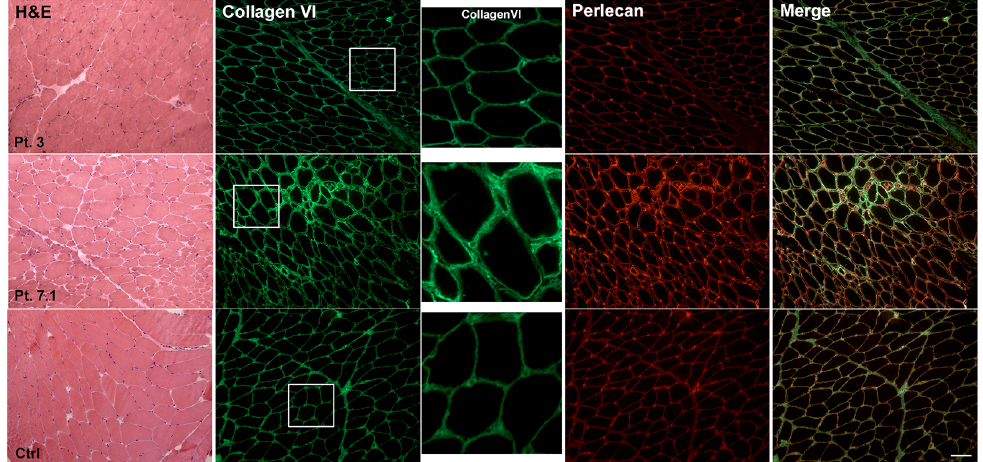
Figure 2. Histology and immunofluorescence on COL6-RM in adult patients. H&E staining shows marked fiber size variability and hypotrophic fibers, predominantly of type II (ATPase staining, data not shown) in Pt 7.1, and no significant changes in Pt 3. Ctrl: aged-matched control muscle biopsy. Scale bar: 50 µ m. Double fluorescent staining for collagen VI (green) and perlecan (red) showed in Pt 3 a staining quite similar to control and a strong signal at the membrane and at the endomysium in Pt 7.1. The inset identifies the high magnification area. Scale bar: 50 µ